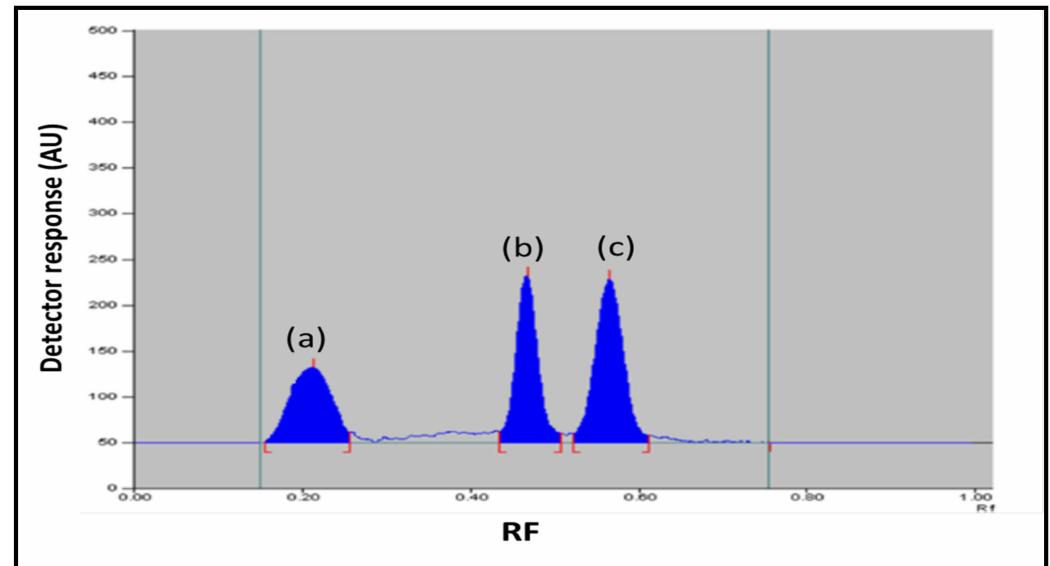
Figure 2. TLC densitogram of ( a ) 3 µ g/band oxidative degradation product of timolol maleate (Rf 0.21), ( b ) 6 µ g/band brinzolamide (Rf 0.46) and ( c ) 3 µ g/band timolol maleate (Rf 0.55) using a developing system consisting of chloroform: methanol: ammonia (6:1:0.5, by volume), at 260 nm.